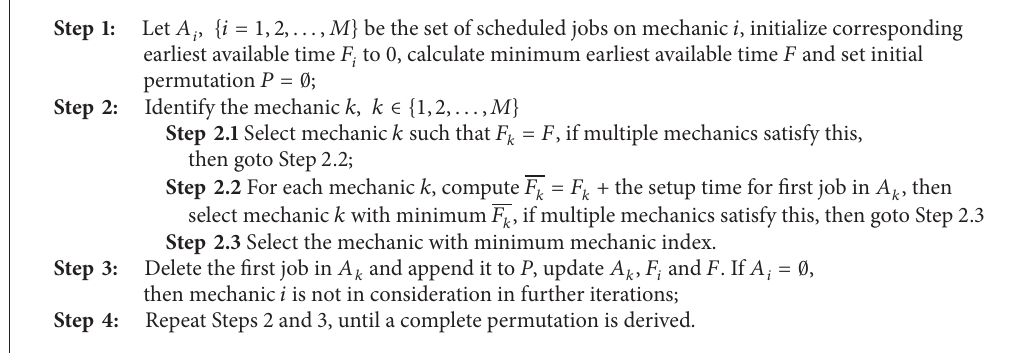
Algorithm 3: Transform schedule into job